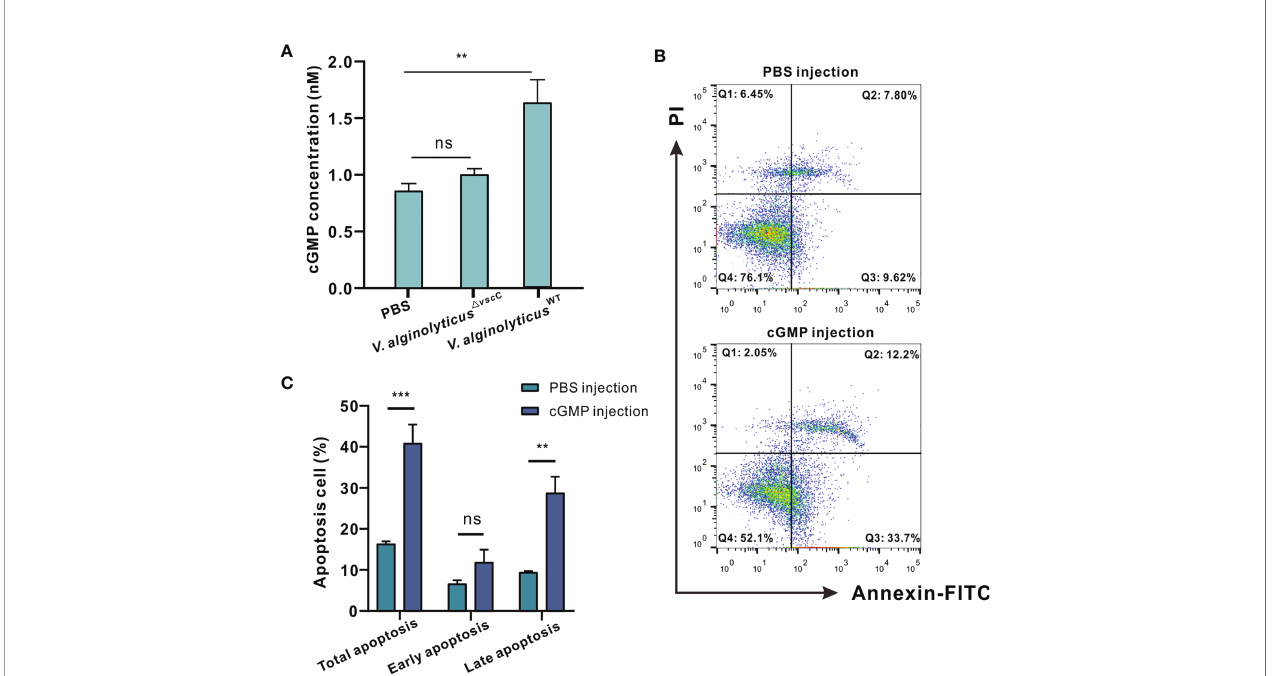
FIGURE 6 | Virulence phenotypes of V. alginolyticus differentially modulate hemocytes apoptosis via cGMP generation. (A) Quanti fi cation of cGMP content in C. hongkongensis hemocytes after challenge with PBS, V. alginolyticus WT or V. alginolyticus △ vscC , as determined by ELISA. cGMP concentrations were calculated by means of a standard curve as shown Supplementary Figure 2 . Statistical difference in the extent of cGMP content of the control, V. alginolyticus WT , and V. alginolyticus △ vscC infection groups were determined by one-way ANOVA and presented as mean ± SEM (n = 3); ns, no signi fi cance; ** p < 0.01. (B) Representative dot-plot results in fl ow cytometry (FACS) analysis on hemocytes apoptosis after PBS or cGMP injection. Q1: necrotic/non-viable cells; Q2: late apoptosis/necrosis; Q3: early apoptosis; Q4: living cells. (C) Statistical evaluation of the proportions of cells undergoing total apoptosis, early apoptosis, and late apoptosis after injection with PBS or cGMP. Data were analyzed by two-way ANOVA and presented as mean ± SEM (n=3); ns, no signi fi cance; ** p < 0.01; *** p <